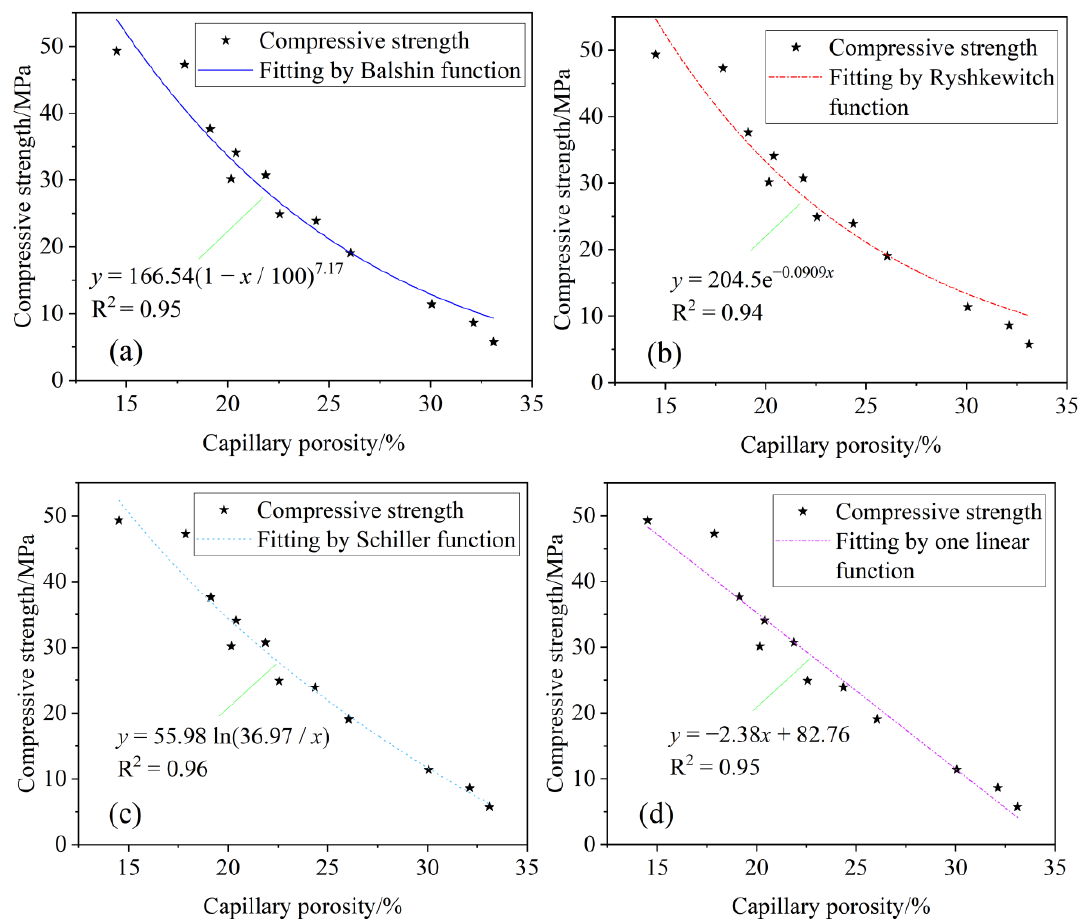
Figure 11. The relationship between compressive strength and capillary porosity of a cement stone. ( a ) Fitting by Balshin function; ( b ) Fitting by Ryshkewitch function; ( c ) Fitting by Schiller function; ( d ) Fitting by one linear function. Table 4. Statistical analysis results of prediction functions of compressive strength.